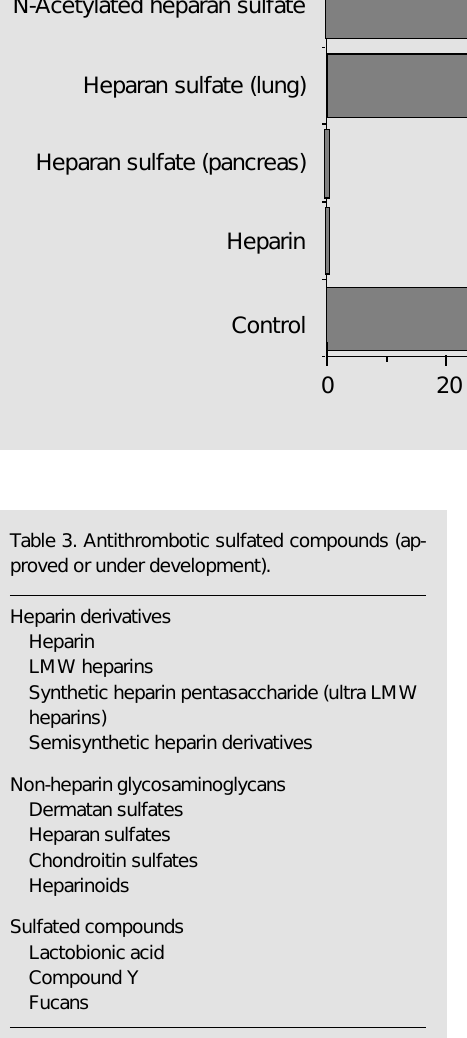
Figure 8. In vivo antithrombotic activity of glycosaminoglycans in an arterial model. Data are from Ref. 17. Note: as authors of this paper we have the right to repro- duce our previous data in re- views.